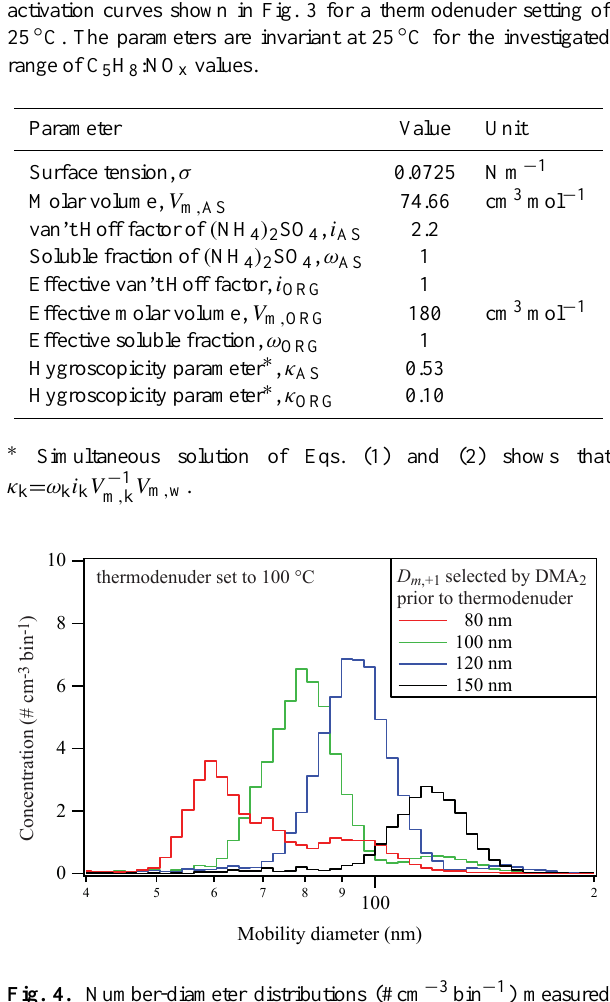
Fig. 4. Number-diameter distributions (#cm − 3 bin − 1 ) measured by SMPS 2 for Experiment 2 after particles have passed through the thermodenuder at 100 ◦ C. Mode diameters shown in the legend cor- respond to the mobility diameters ( + 1 charge equivalent) selected by DMA 2 prior to evaporation in the thermodenuder.